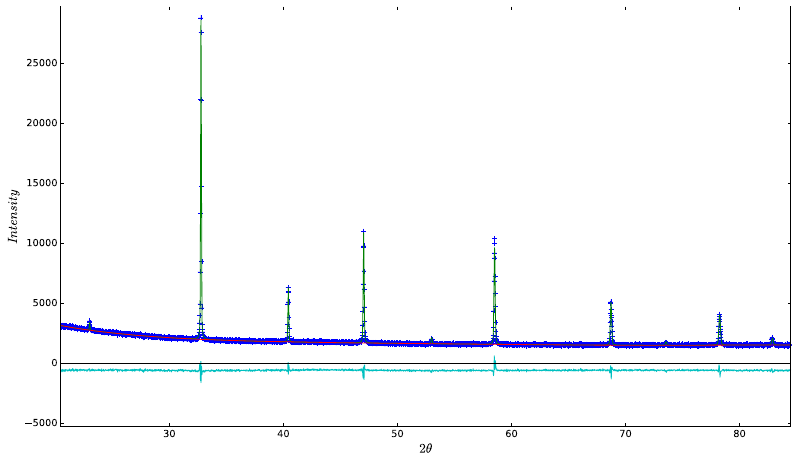
Figure 11. Observed, calculated and difference X-ray diffraction profile for SrFe 0.95 B 0.05 O 3- δ .